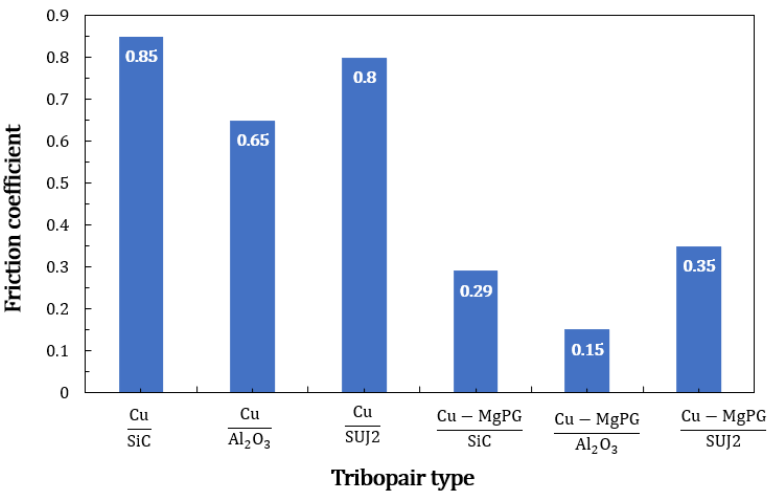
Figure 5. The average friction coefficients of tribopairs.